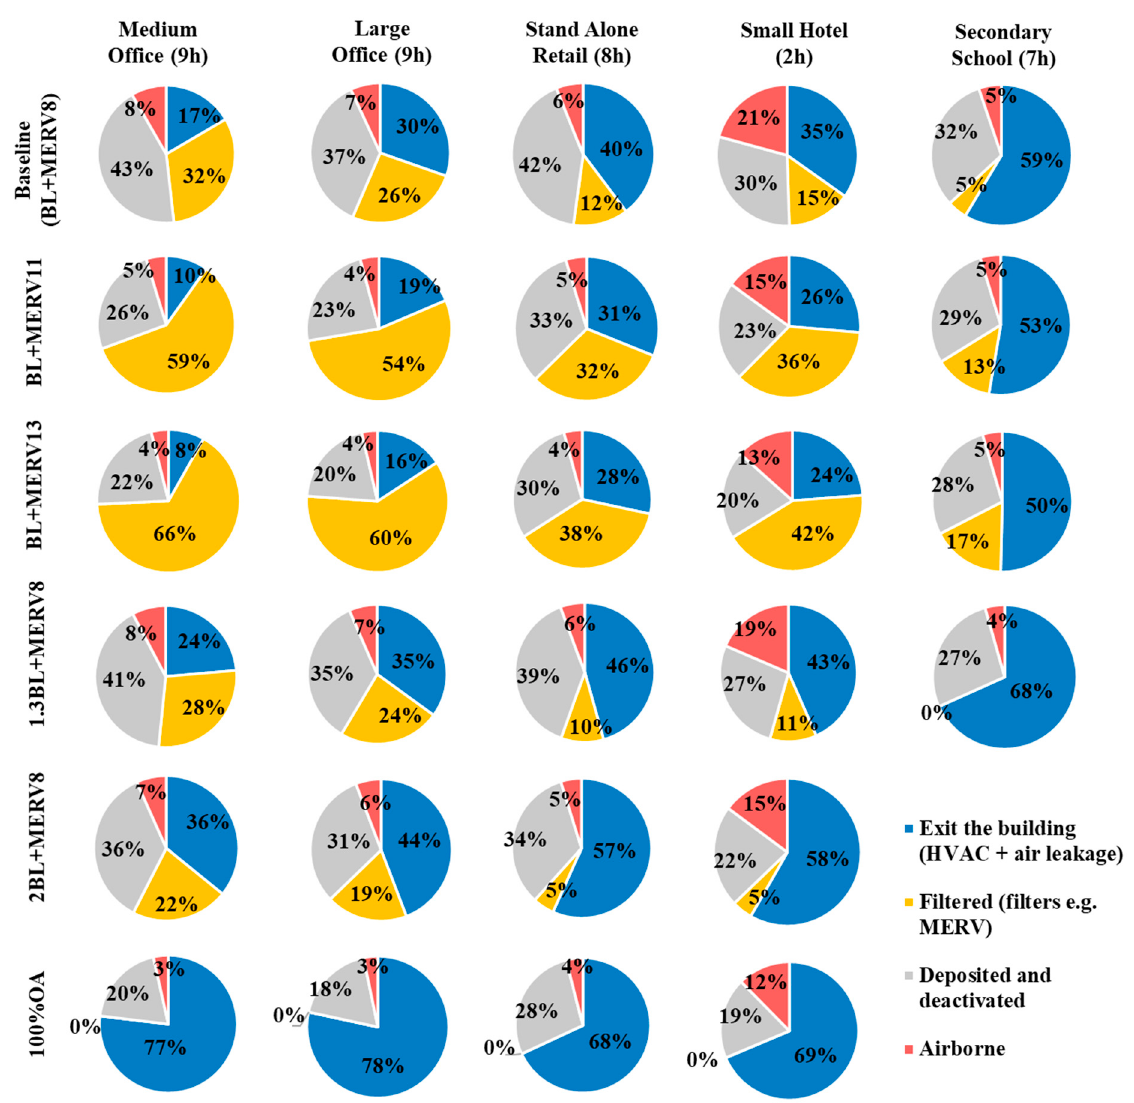
Figure 11. Quanta fate of released quanta during susceptible exposure duration. Infector was in the core zone of all buildings, except for small hotel and school, where they were in the meeting room and classroom, respectively. Susceptible duration information is indicated in the column labels (also see Table 1).